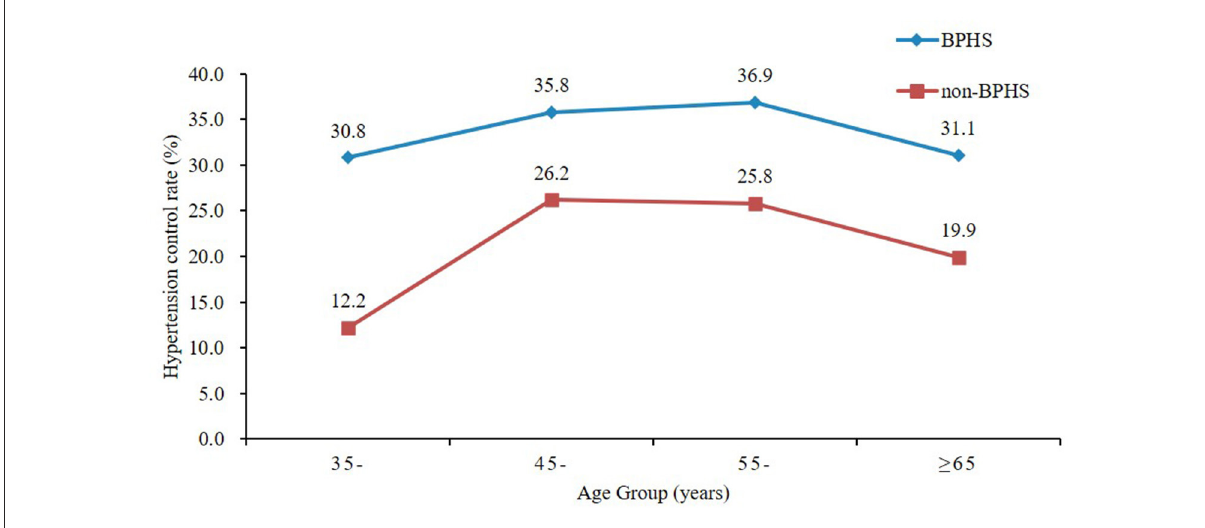
FIGURE4 Hypertension control rate by age between the BPHS and non-BPHS groups.